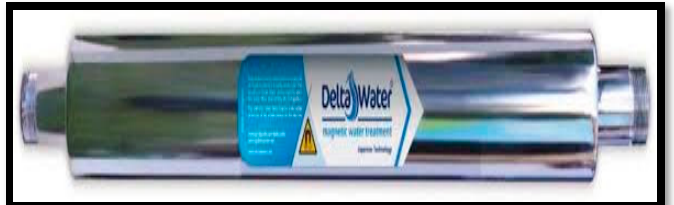
Figure 1. Delta water magnetic device.